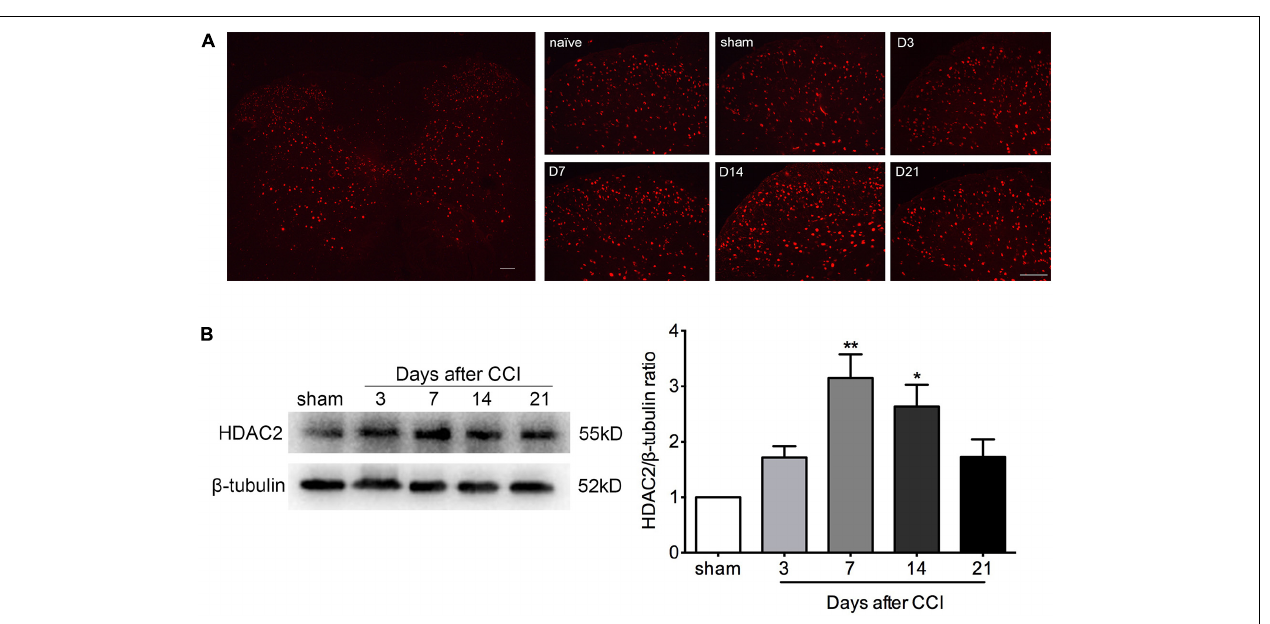
day 14, 1.0 vs. 2.639 ± 0.3925, p = 0.0193; n = 4 for each group) ( Figure 2B